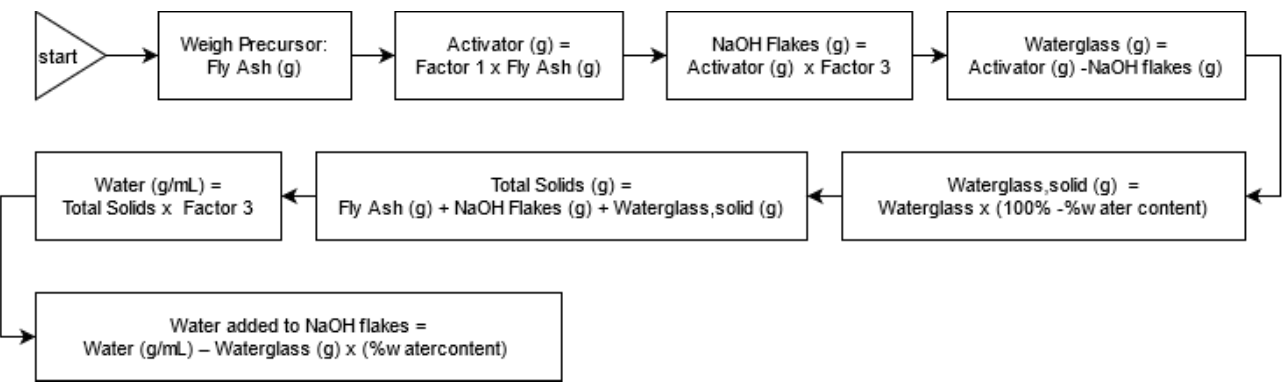
Figure 1. Guideline for the computation of the mass of each component for each run from the factors in Table 6.